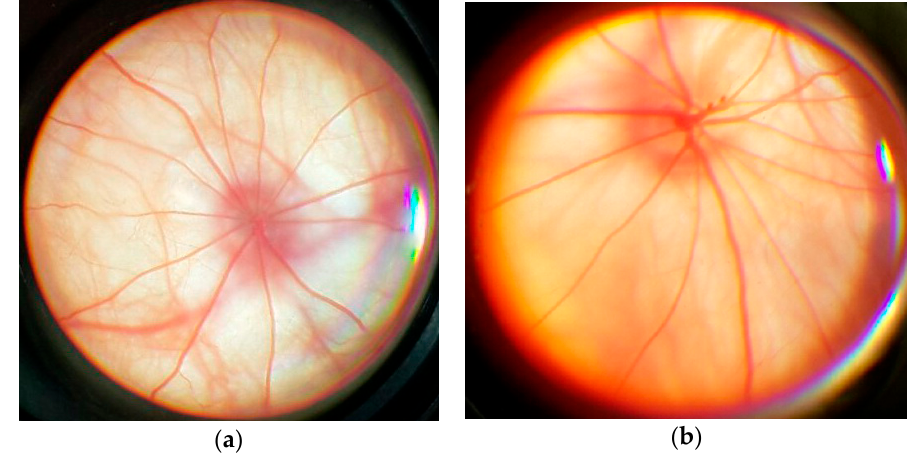
Figure 5. An example of an ophthalmoscopic picture in rats with the simulated retinal ischemia-reperfusion: ( a ) with the correction by L -isomer of ethylmethylhydroxypyridine malate; ( b ) with the correction by Emoxipine.